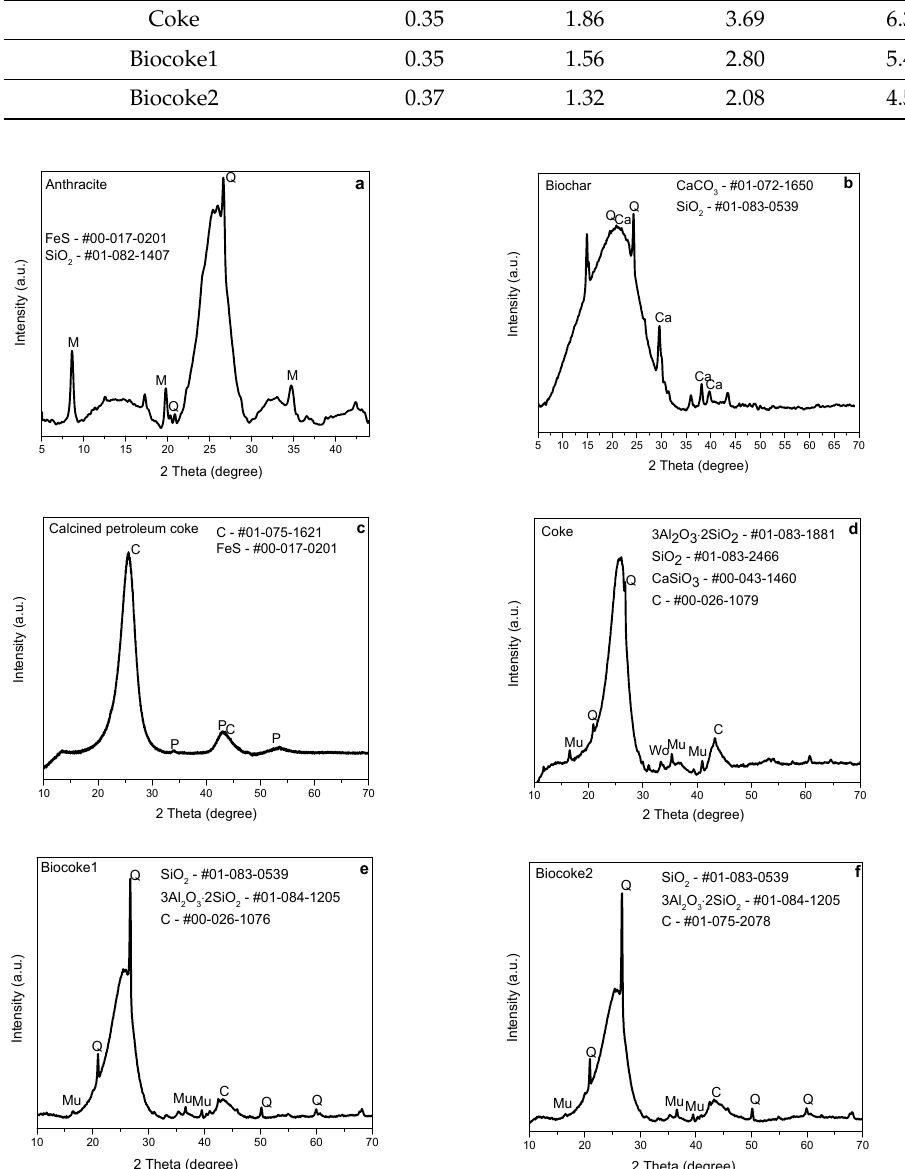
Figure 6. The XRD spectra of mineral matter of carbon-bearing sources: ( a ) anthracite; ( b ) biochar; ( c ) calcined petroleum coke; ( d ) coke; ( e ) biocoke1; and ( f ) biocoke2. Q is quartz, M is muscovite, Ca is calcite, C is graphite, P is pyrite, Mu is mullite, and Wo is wollastonite. The minerals of the cokes were not significantly different, but wollastonite (CaSiO 3 ) was also found in the coke [54]. Additionally, a weak peak was observed at approximately 43 ◦ 2 θ and was assigned to the (101) plane reflection of